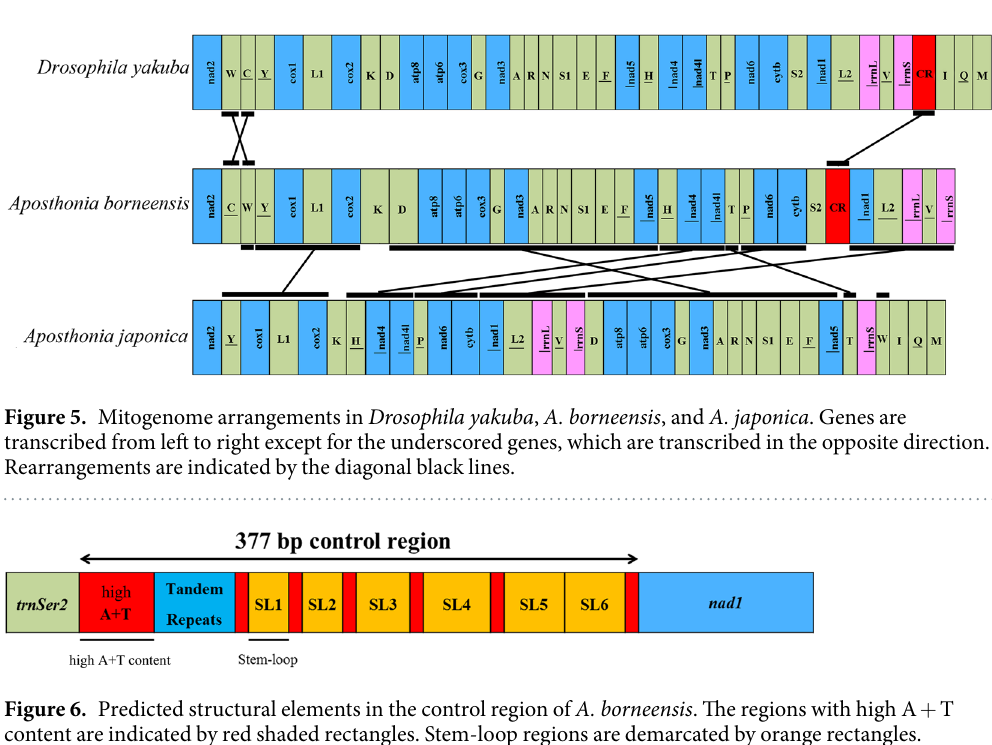
66-bp region with high A + T content (90.9%); a 44-bp region containing two complete and one incomplete tan- dem repeats; and six stem-loop structures (SL) (Fig. 6). The small size of tandem repeats may explain the relatively small CR in A. borneensis when compared to other insects 18, 19 . The tandem repeats and SL structures in the CR have potential regulatory effects on mitogenome replication and transcription 20 .